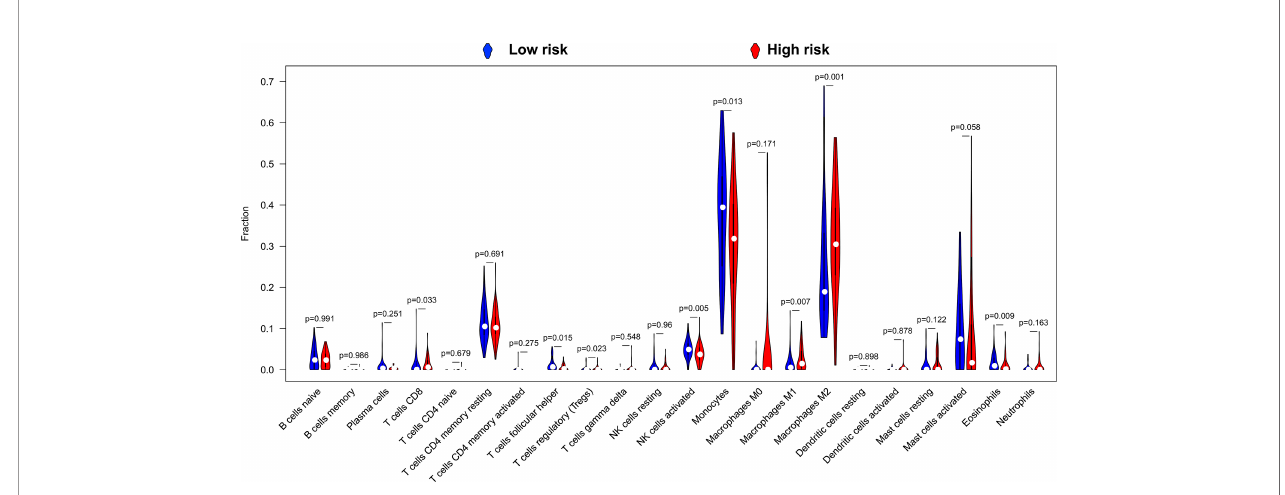
FIGURE 11 | Violin plot of 22 immune cells in fi ltration between high- and low-risk score phenotypes.